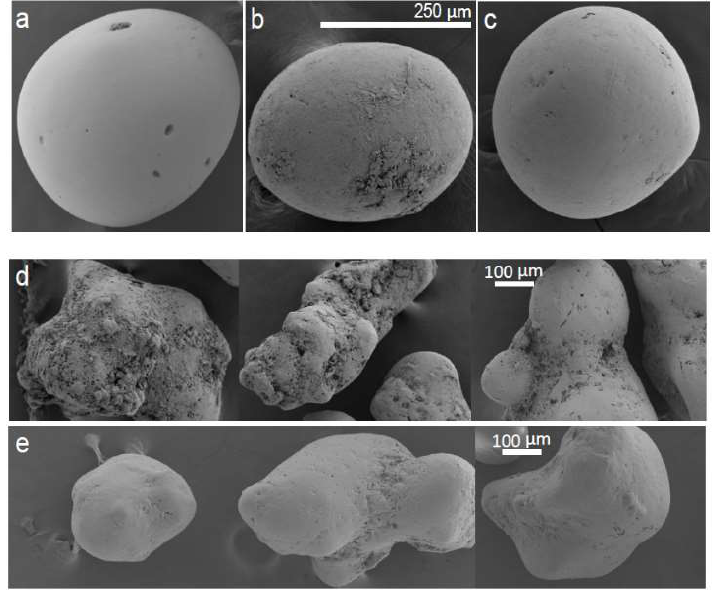
Figure 5. Representative SEM images of ooids in the 250–500 µm diameter range from two locations along the transect. ( a ) Ooids from the barren area at a distance of 20 m from the shore have a smooth and polished surface. ( b ) Ooids from the microbially covered area at a distance of 100 m from the shore have an irregular surface due to the presence of microcrystalline carbonate. ( c ) Representative image of ooids from the same area as in ( b ), but after 24 h of erosion in the laboratory. ( d , e ) Representative images of grapestones collected at 150 m from the shore before ( d ) and after ( e ) laboratory abrasion.